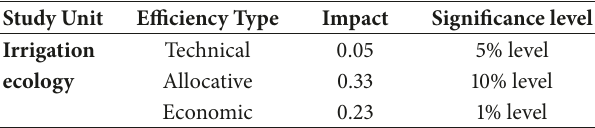
Table 10: Summary of impact of irrigation ecology on technical, allocative, and economic